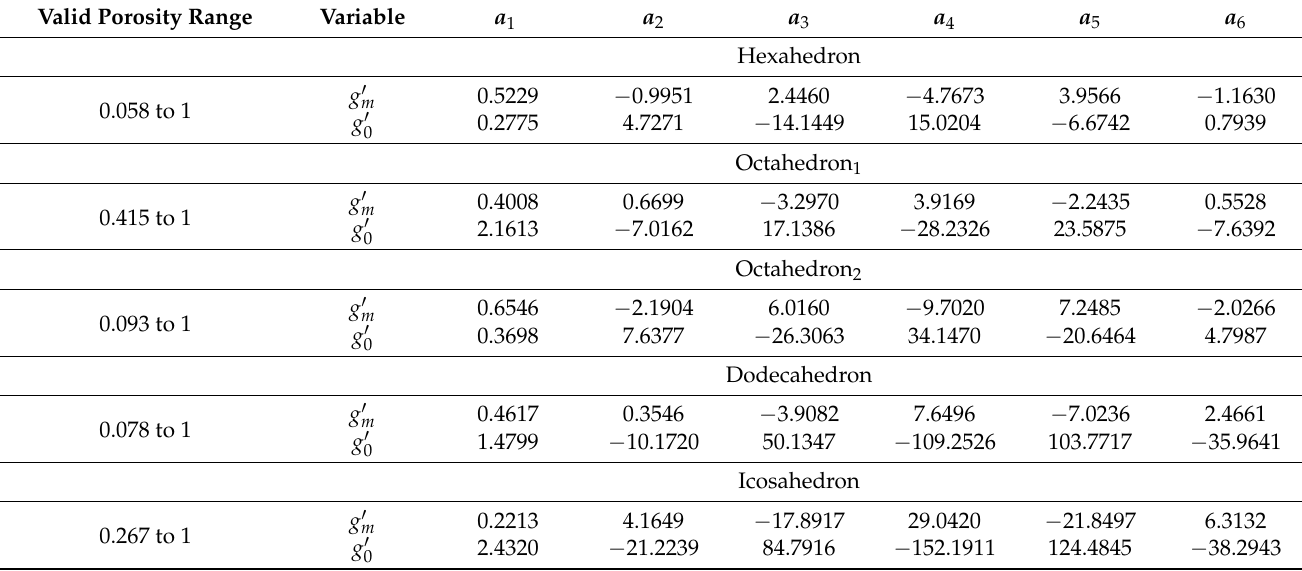
and g (cid:48) m 0